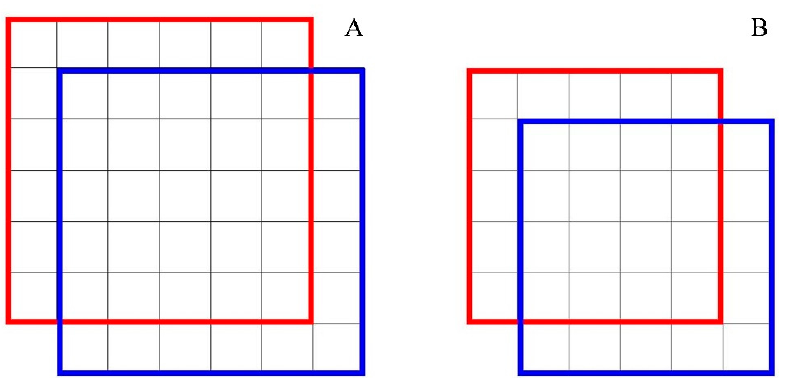
Figure 11. Illustration of the IoU value di ff erence for the same o ff set in pixels but for di ff erent size objects. The IoU of the left boxes ( A ) is 0.53, and the IoU of right the boxes ( B ) is 0.47. Although both of them has the same o ff set (one pixel) in the same direction, the left detection is true positive while the right one is false positive with IoU threshold of 0.5.